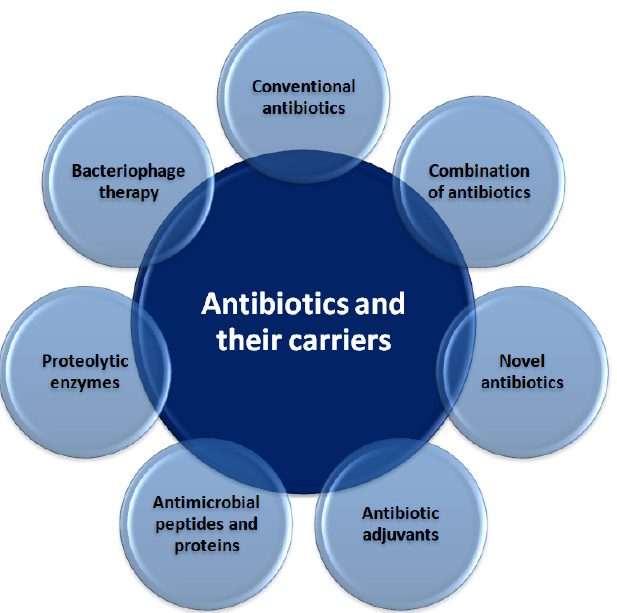
Figure 3. Schematic representation of antibiotic ‐ based strategies for controlling the formation of clinically important biofilms.